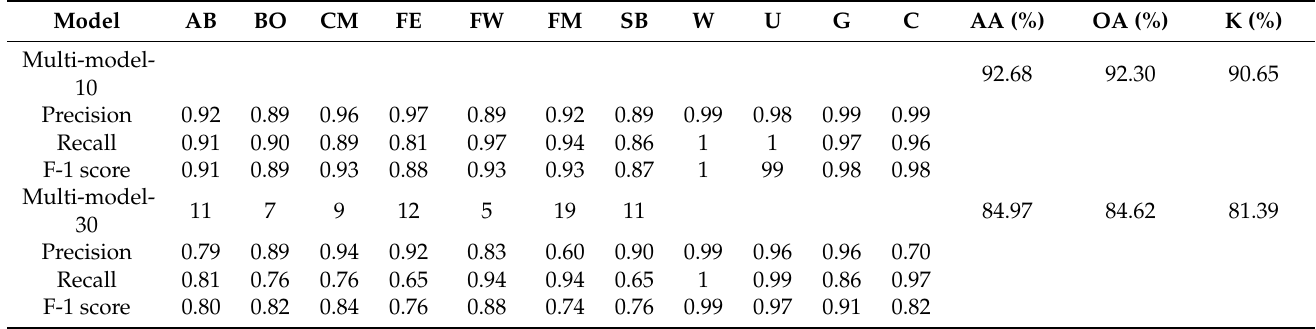
Table 6. Results of the proposed multi-model for different spatial resolutions in terms of average accuracy, precision, F1-score, and recall (AB = aquatic bed, BO = bog, CM = coastal marsh, FE = fen, FM = freshwater marsh, FW = forested wetland, SB = shrub wetland, W = water, U = urban, G = grass, C = crop, AA = average accuracy, OA = overall accuracy, K = kappa, 10 = 10 m spatial resolution, and 30 = 30 m spatial